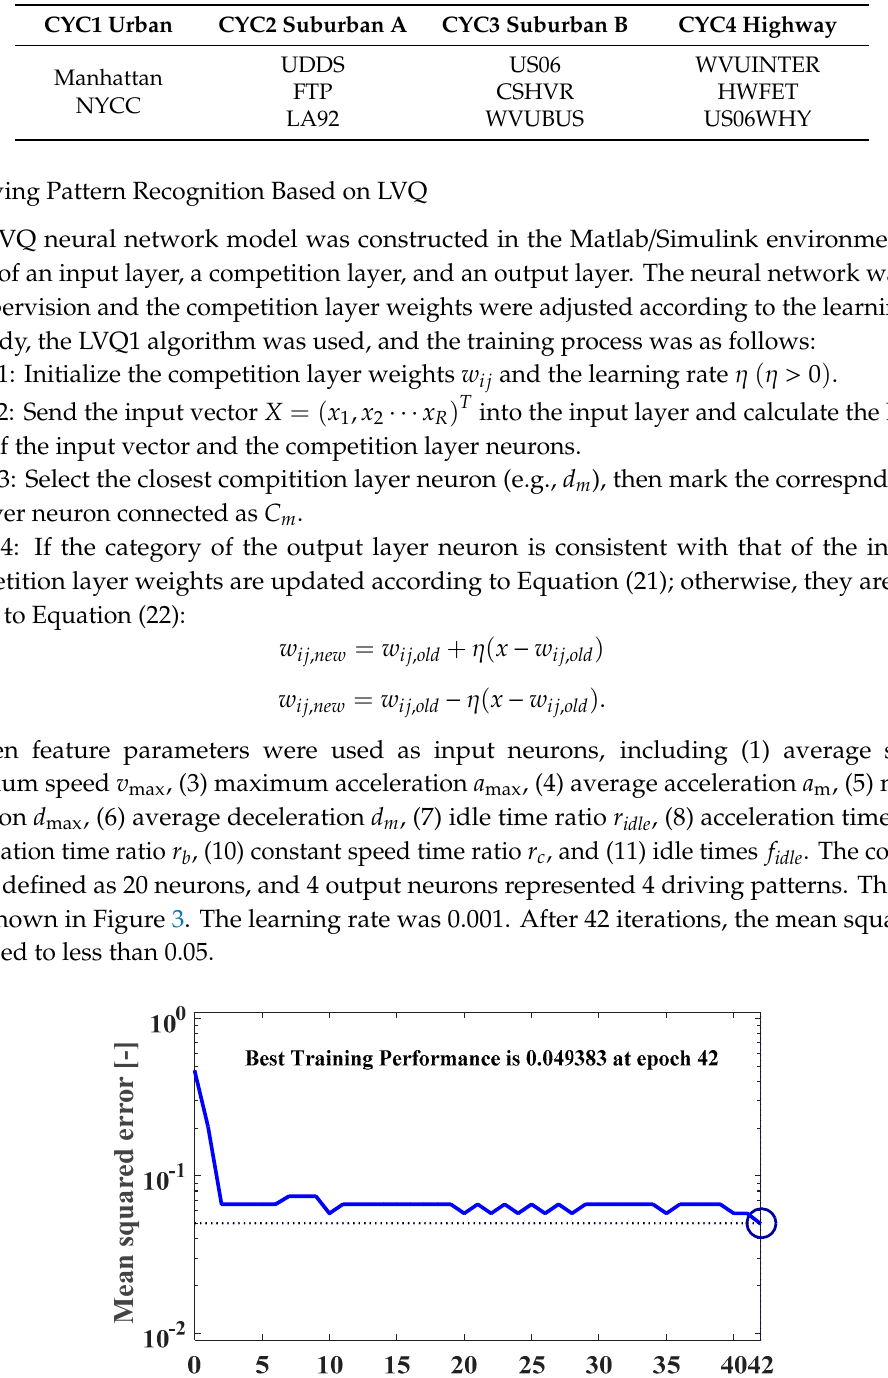
Table 3. Classification of the standard driving cycles.